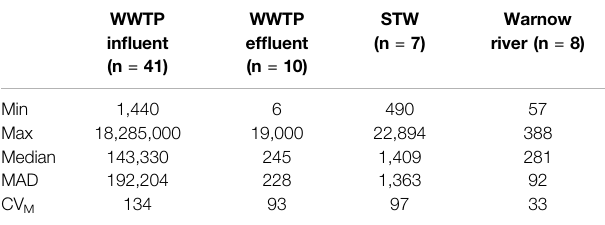
TABLE 5 | Descriptive statistics for microplastic concentrations utilized for emission estimates. Data was obtained from the literature for wastewater treatment plant (WWTP) in fl uents, ef fl uents, and stormwater (STW). Microplastic concentration per m 3 . IQR: interquartile range, MAD: median absolute deviation, CV M : coef fi cient of variability for median. n: number of microplastic